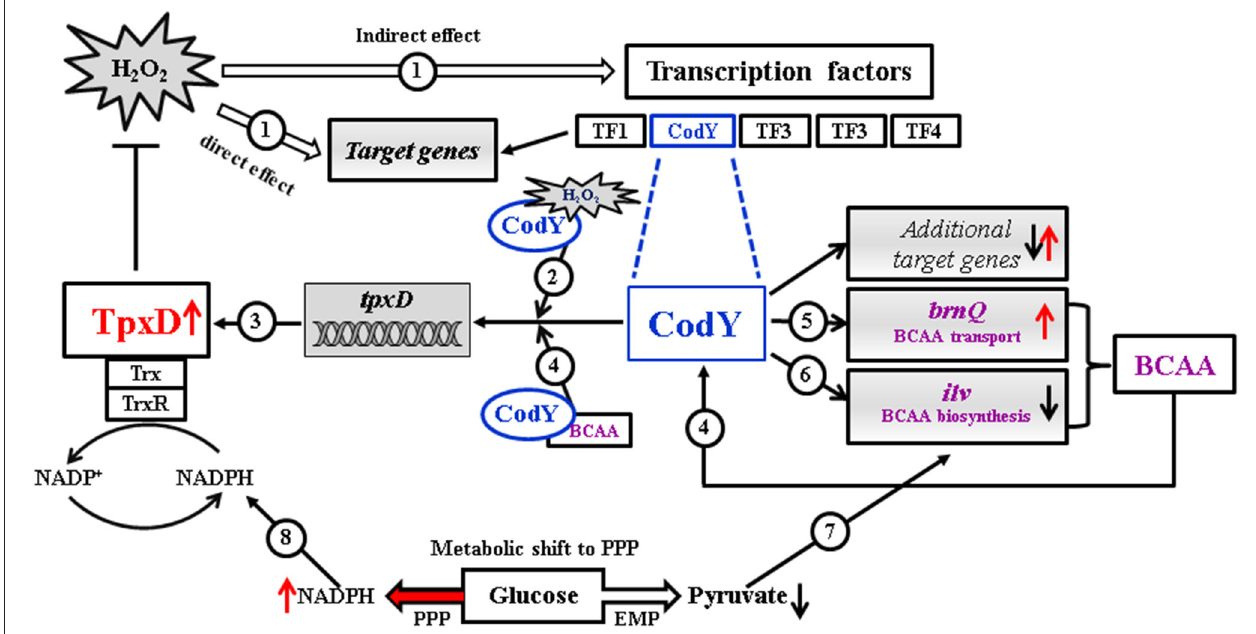
FIGURE 6 | Proposed schematic model illustrating the contribution of TpxD and CodY to the pneumococcal global transcriptional response to H 2 O 2 . Under oxidative stress conditions H 2 O 2 activates directly or indirectly a cascade of genes and transcription factors (TF), among them CodY (1). We speculate that CodY activation by H 2 O 2 is due to a conformational change originating from specific cysteine oxidation (2). As a result, CodY binding to tpxD regulatory sequence is enhanced, leading to TpxD up-regulation (3), thereby preventing the accumulation of high H 2 O 2 levels. BCAA are known to enhance CodY binding to DNA (4), thereby inducing tpxD expression (3). Under oxidative stress conditions, CodY modulates the intracellular level of BCAA through the up-regulation of the BCAA transporter, brnQ (5) and down-regulation of the BCAA biosynthetic machinery ( ilv ) (6). Consequently, the need for pyruvate, which is the central precursor in BCAA biosynthesis, is expected to decrease (7) leading to a shift in glucose catabolism toward the pentose phosphate pathway (PPP). This metabolic shift will result in increased NADPH formation (8), thus enhancing TpxD recycling by the thioredoxin-thioredoxin reductase